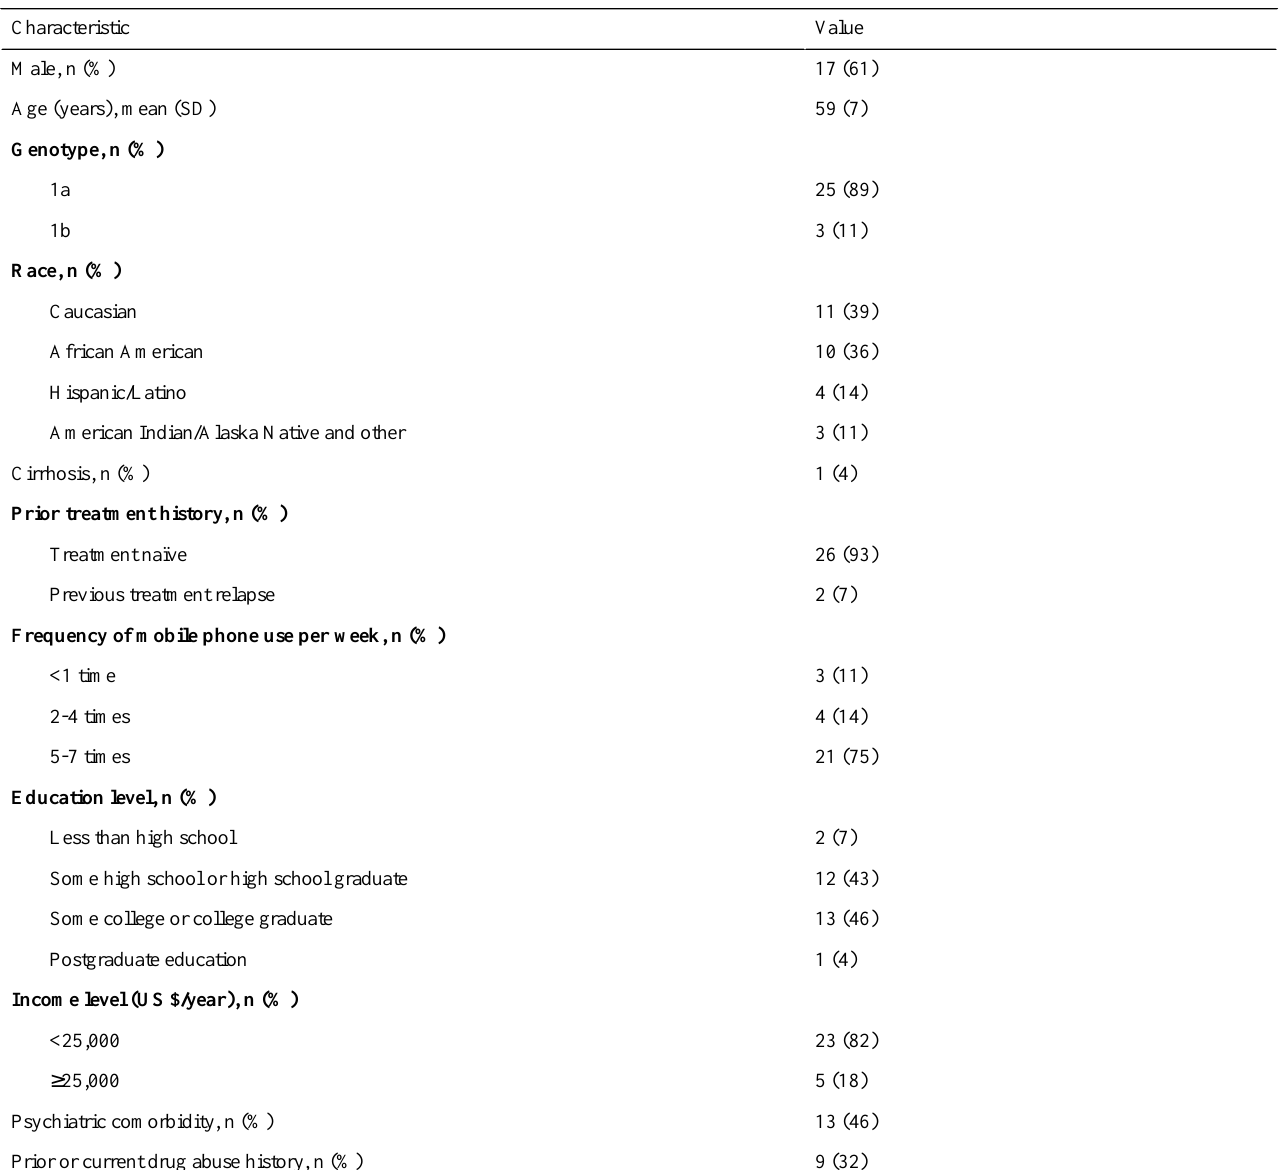
Table 1. Baseline demographics and characteristics (N=28).